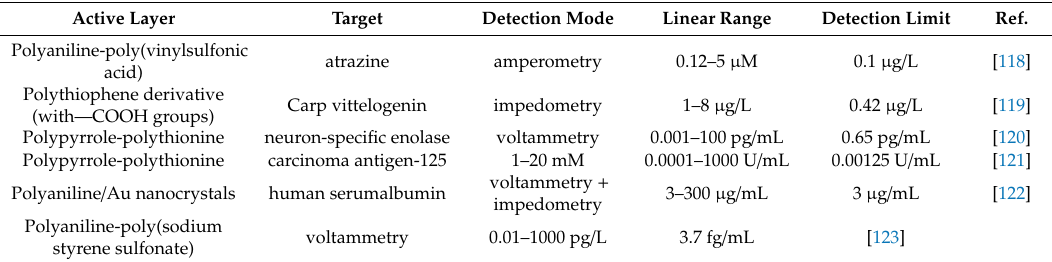
Table 3. Comparison of conducting polymer-based immunosensor